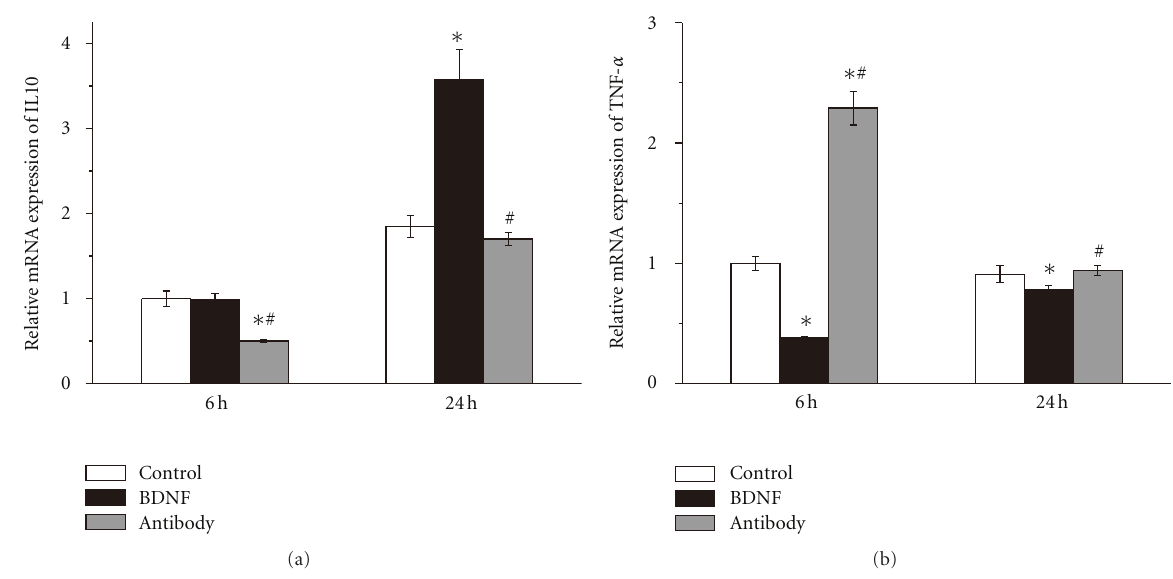
Figure 6: E ff ect of BDNF on mRNA expression of cytokine brain homogenates were obtained from ischemic cortexes 6h and 24h after reperfusion. The expressions of mRNA of interleukin10 (IL10) and tumor necrosis factor α (TNF- α ) in rat brain after stroke were measured by real-time quantitative polymerase chain reaction (PCR). (a) Levels of IL10 mRNA. Application of BDNF antibody prevented upregulation of IL10 mRNA 6h after reperfusion. At 24h of reperfusion, BDNF increased level of mRNA of IL10 by 1.93 fold. (b) Levels if TNF- α mRNA. Exogenous BDNF significantly decreased mRNA of TNF- α 6h and 24h after reperfusion. Inhibition of endogenous BDNF significantly increased the expression of TNF- α 6h after reperfusion. Bars represent mean ± SD ( n = 6). ∗ P < . 05 versus control group, # P < . 05 versus BDNF